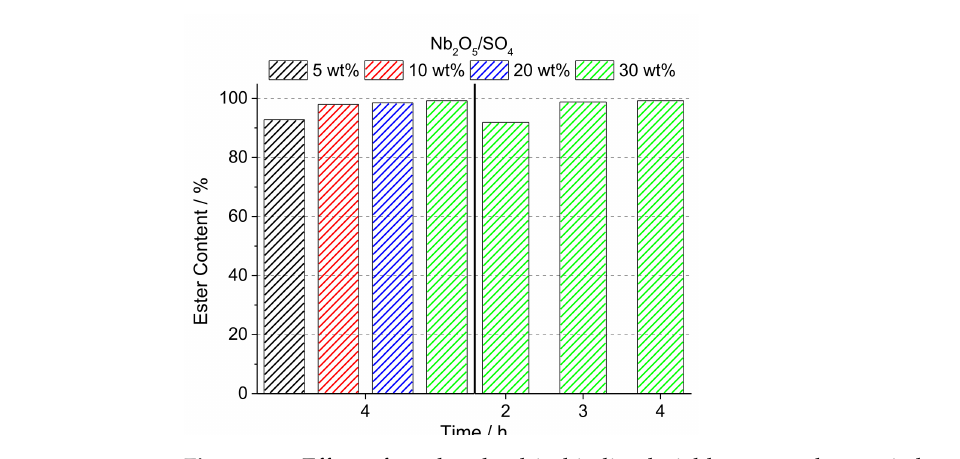
Figure 12. Effect of catalyst load in biodiesel yield measured at varied reaction time intervals. Reaction conditions: molar ratio ethyl alcohol: macaw palm oil (120:1), catalyst concentration (5–30 wt%), temperature (250 ◦ C) (adapted from [66]).